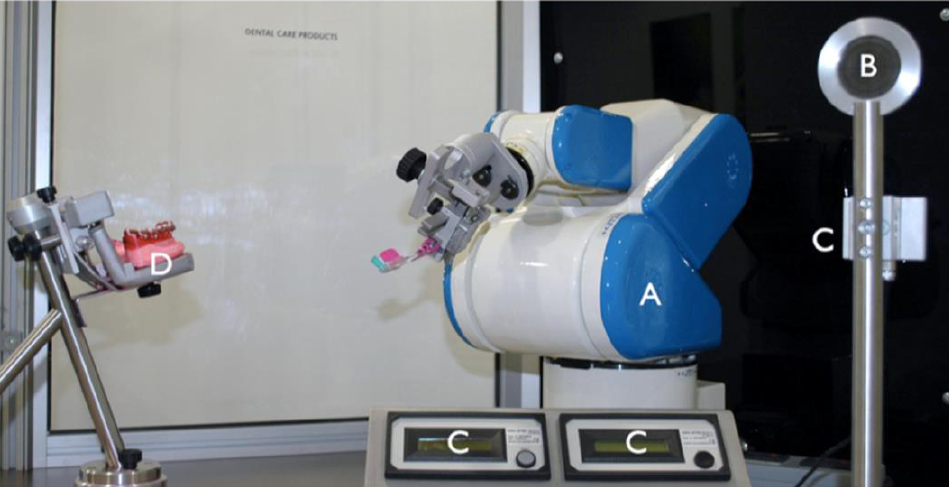
Figure 6. Overview of the toothbrushing simulation unit. A: six-axis robot. B: Calibrating graticule. C: Two shields for calibrating the brushing force. D: Mounting plate for mandibular typodont dentition 38 – 50 [51] .